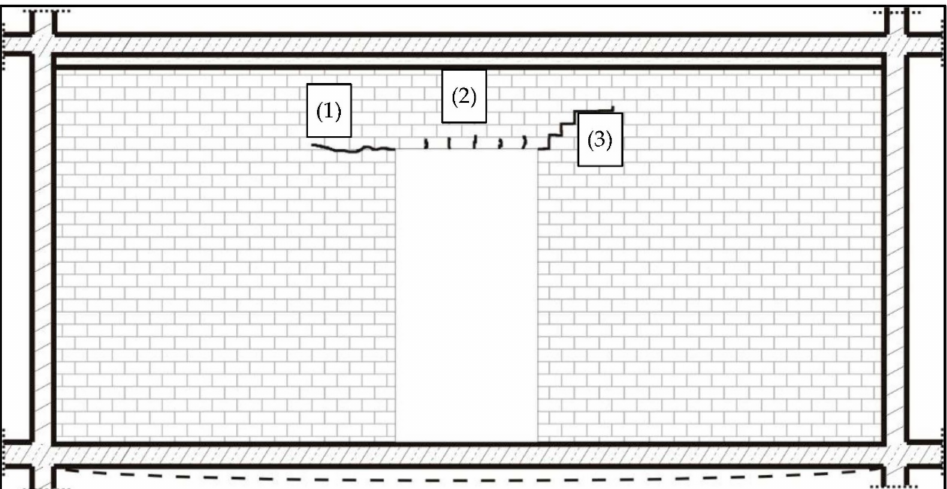
Figure 20. Character and sequence of wall cracks on the wall not connected with cross walls; ( 1 )—horizontal crack; ( 2 )—vertical crack; and ( 3 )—oblique